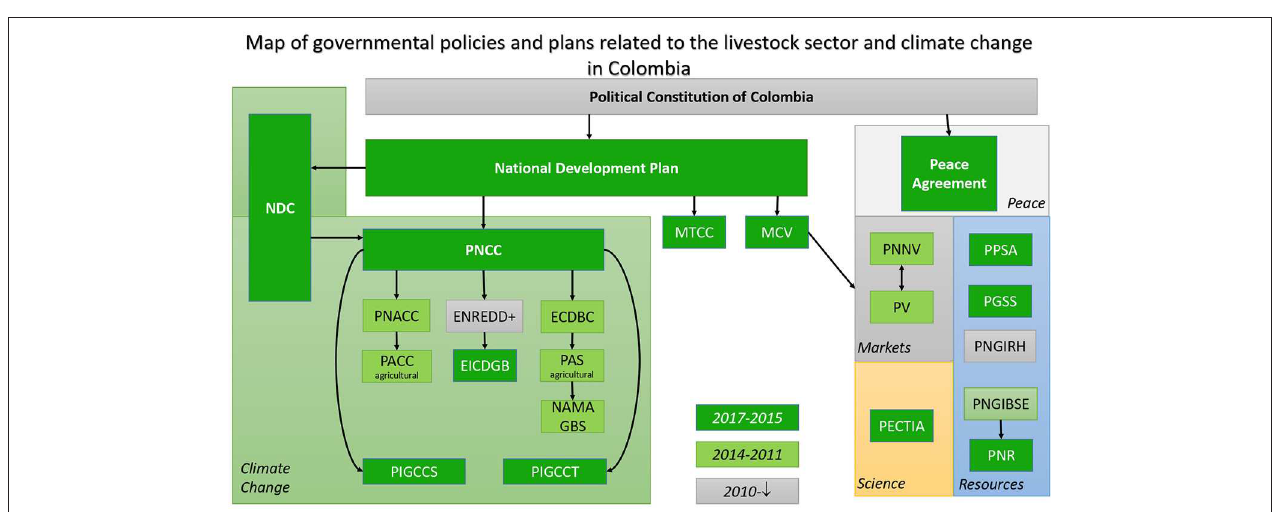
FIGURE 1 | Timeline of relevant activities in the livestock sector and climate change in Colombia.